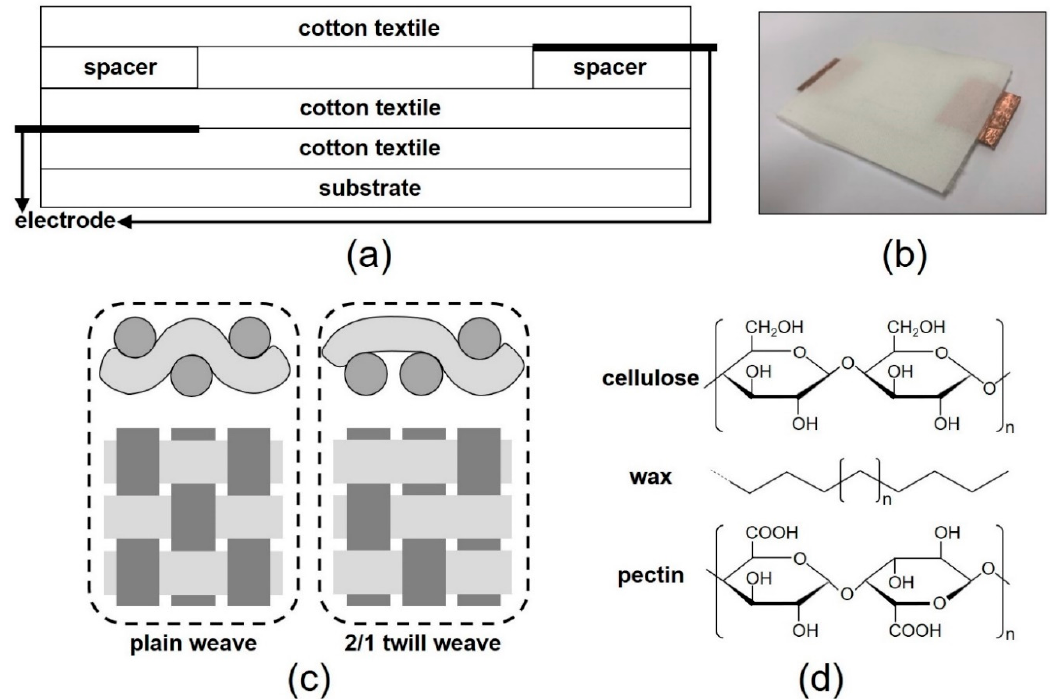
Figure 1. ( a ) Schematics of the cotton-textile-based triboelectric nanogenerator, ( b ) a photo of the fabricated TENG, ( c ) plain and 2 / 1 twill weave patterns, and ( d ) the molecular structures of cellulose, wax, and pectin.